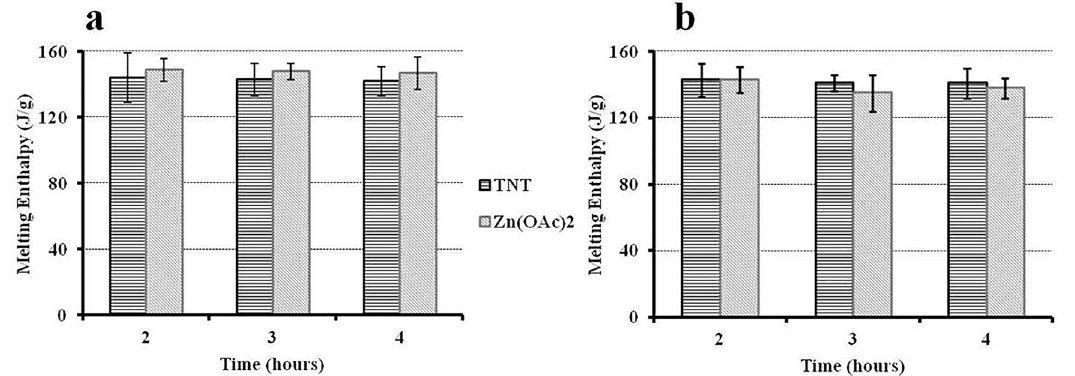
Figure 5. Enthalpies of fusion for BHET from: a) virgin PET and b) post-consumer PET.